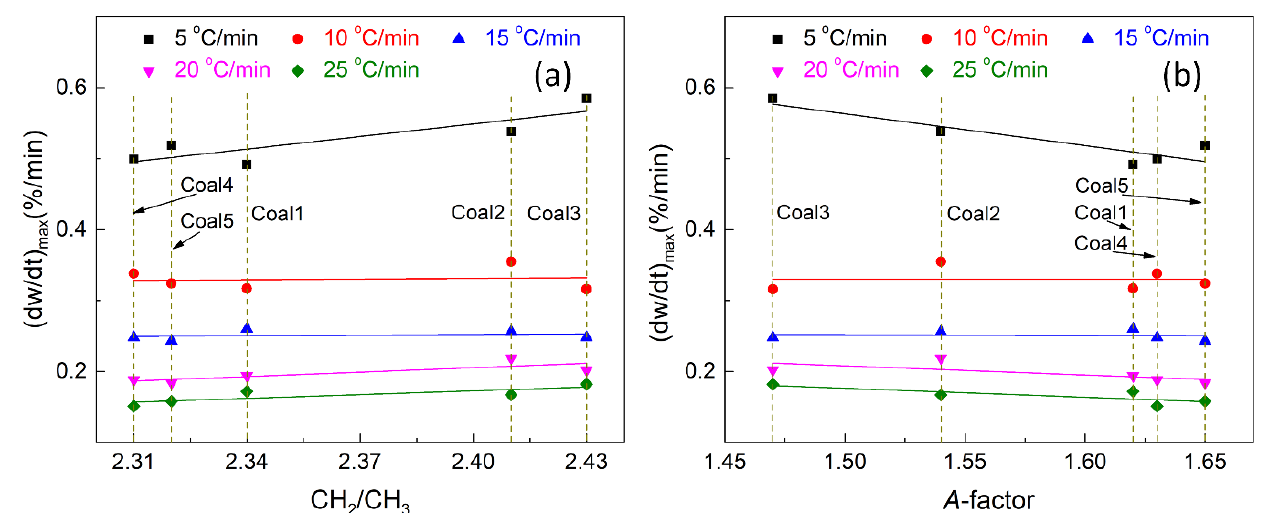
Figure 9. Relationship between maximum combustion rate and coal structure from ATR-FTIR anal- ysis: ( a ) CH 2 /CH 3 and ( b ) A -factor. analysis: ( a ) CH 2 /CH 3 and ( b ) A